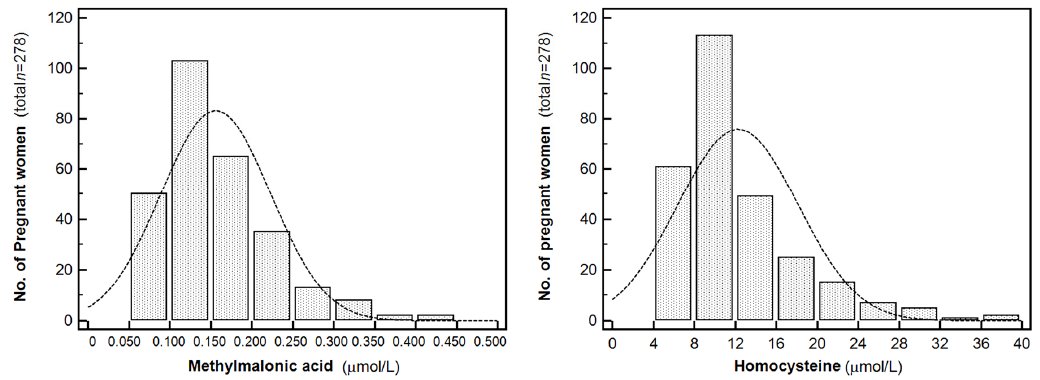
Figure 1. The distribution of methylmalonic acid and homocysteine levels in 278 Korean pregnant women.